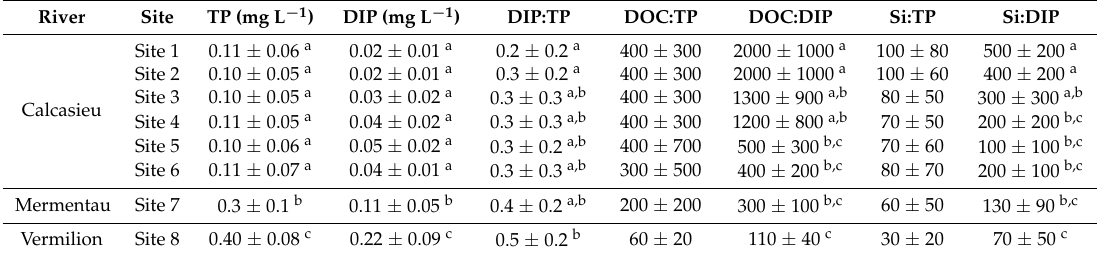
Table 4. TP and DIP concentrations and ratios as well as dissolved organic carbon (DOC) and silicon to phosphorus ratios at six sampling sites along the Calcasieu, Mermentau, and Vermilion Rivers entering the Northern Gulf of Mexico in the southern United States. Tukey-Kramer’s adjustment was used to group sampling sites when ANOVA shows significant differences among sites. Means with the same superscript letter (a, b, or c) are not significantly different at the 0.05 level (Tukey groupings).